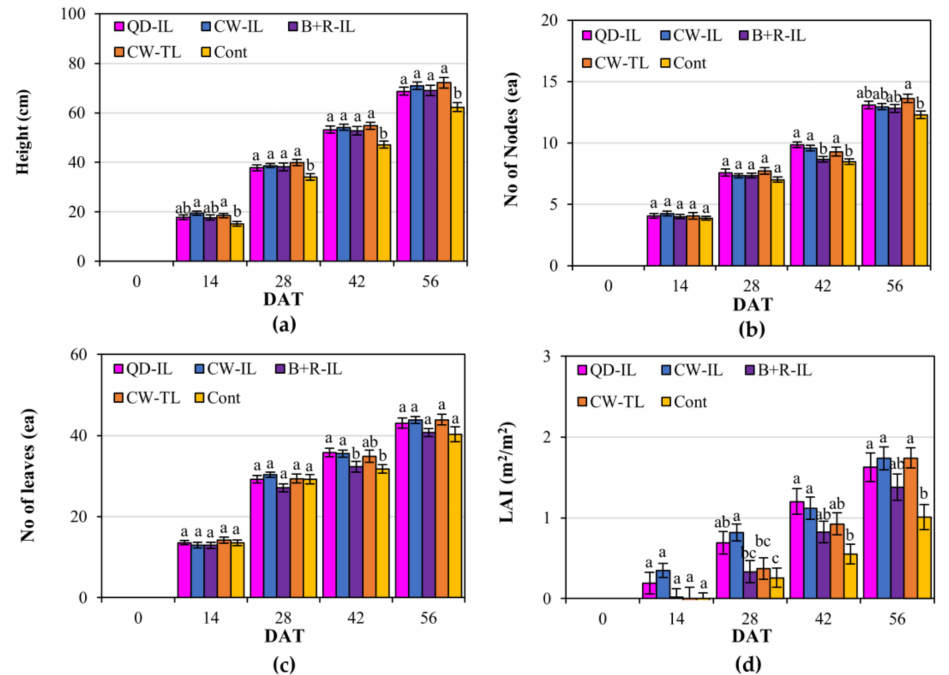
Figure 1. Variance in paprika plant growth during supplemental lighting application. ( a ) Height, ( b ) number of nodes, ( c ) number of leaves, and ( d ) leaf area index (LAI) increased compared with the initial values. Supplemental lighting treatments: QD-IL, QD inter-lighting; CW-IL, cool-white inter-lighting; B+R-IL, blue + red inter-lighting; CW-TL, cool-white top-lighting; Cont, without supplemental lighting. Vertical bars indicate ± SEM (n = 21). Values marked with different letters indicate significant differences according to Duncan’s multiple range test at the 5% level.